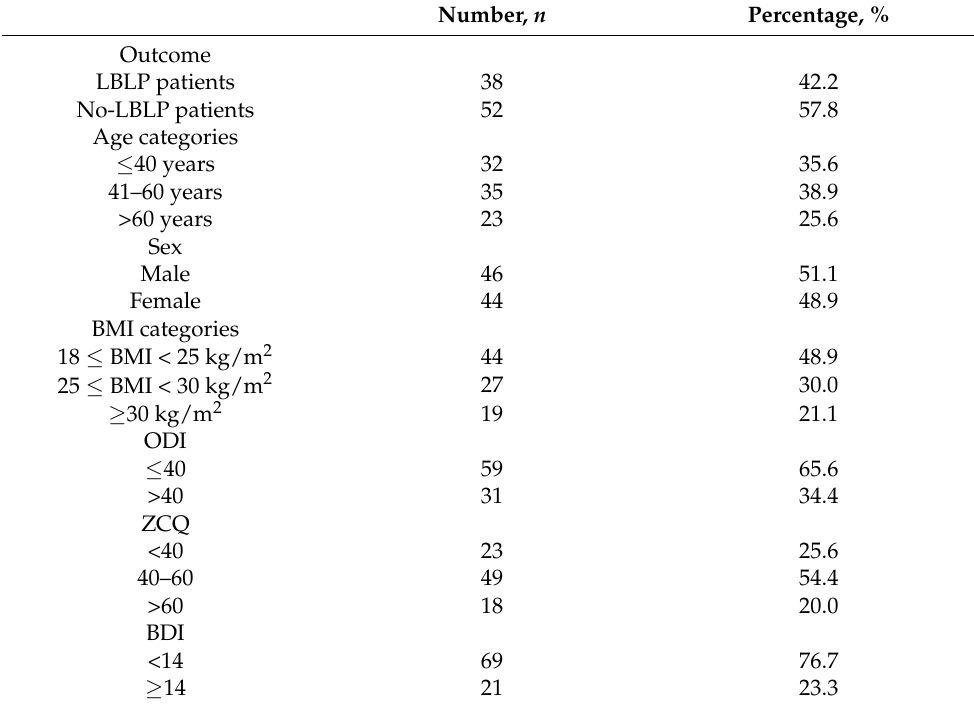
Table 2. Baseline characteristics of patients included in the study.